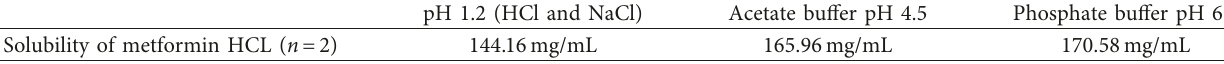
Table 1: Results from the solubility test of metformin HCL in the proposed dissolution media.